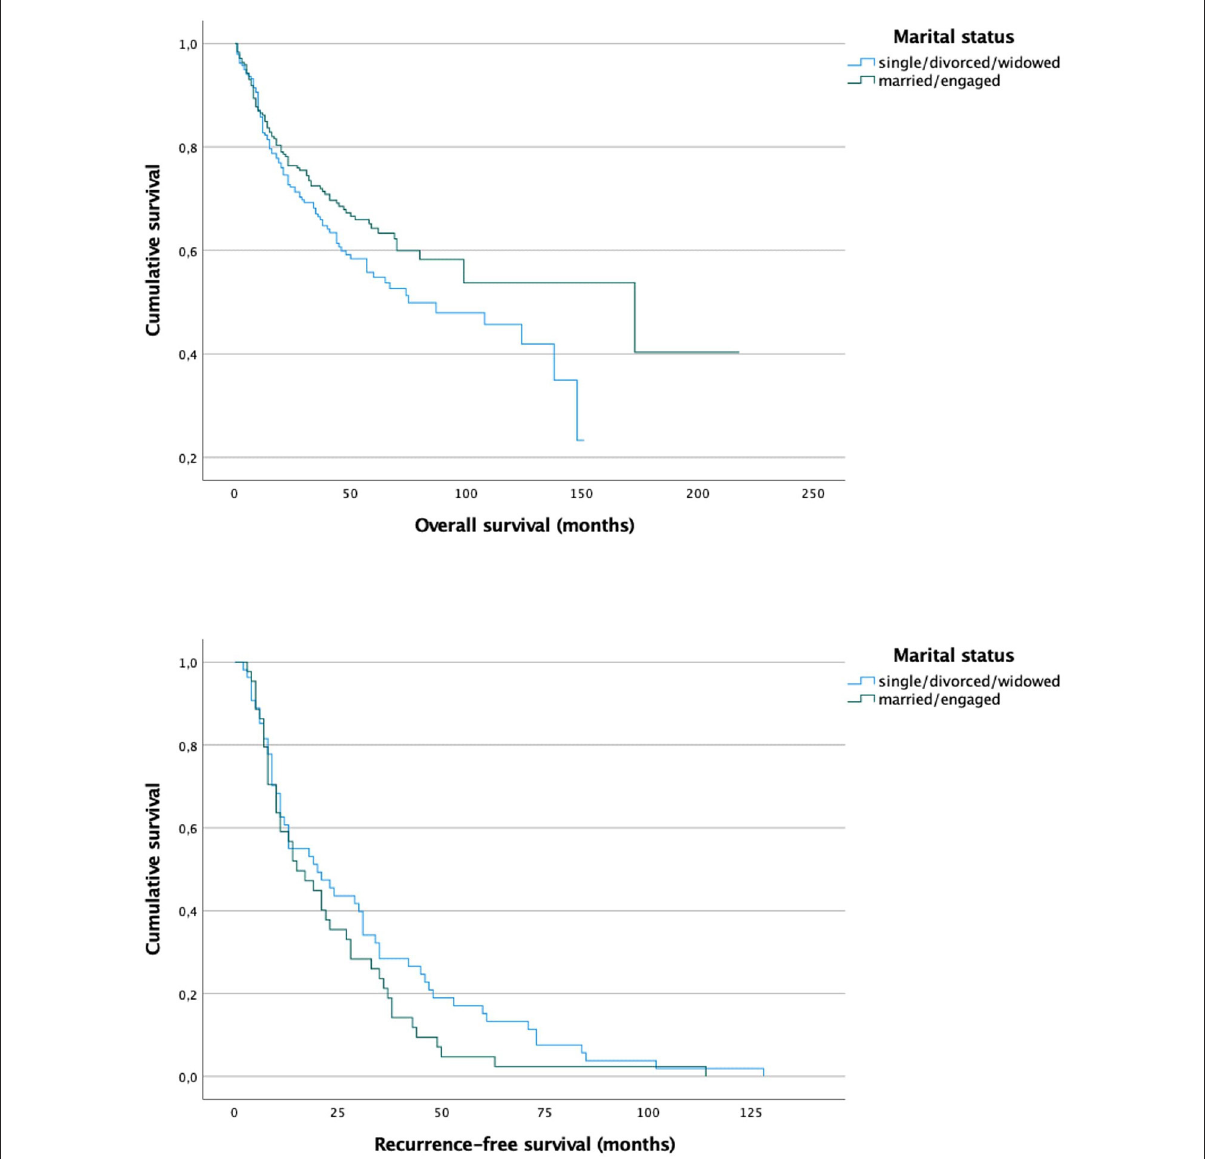
FIGURE2 Survival curves for patients that are married/engaged (mean overall survival 10.6 years) and patients who are single/divorced/widowed (mean overall survival 7 years) show a difference, which slightly misses significance for overall survival ( p = 0.068) but seems not to be significant for recurrence-free survival ( p =